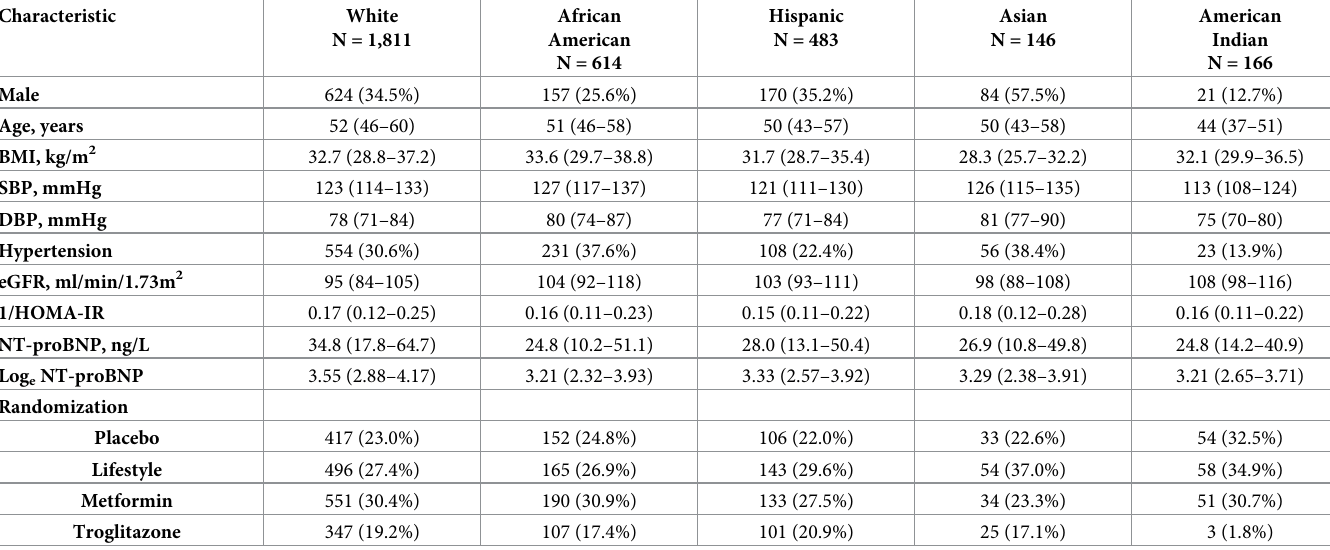
Table 1. Baseline characteristics of DPP participants according to